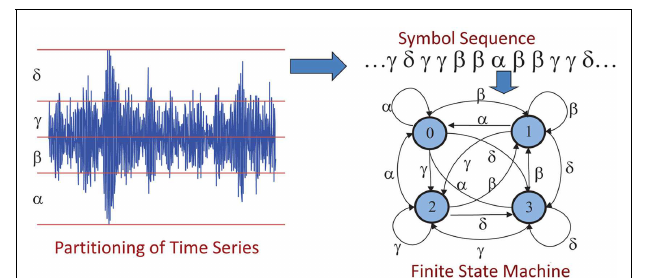
FIGURE 2 | Construction of finite state automata (FSA) for symbolic dynamic filtering (SDF)